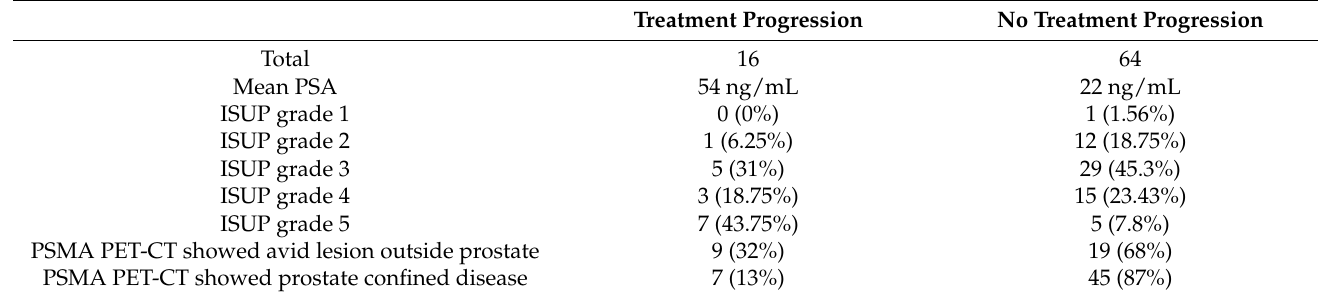
Table 5. No treatment progression vs. treatment progression.